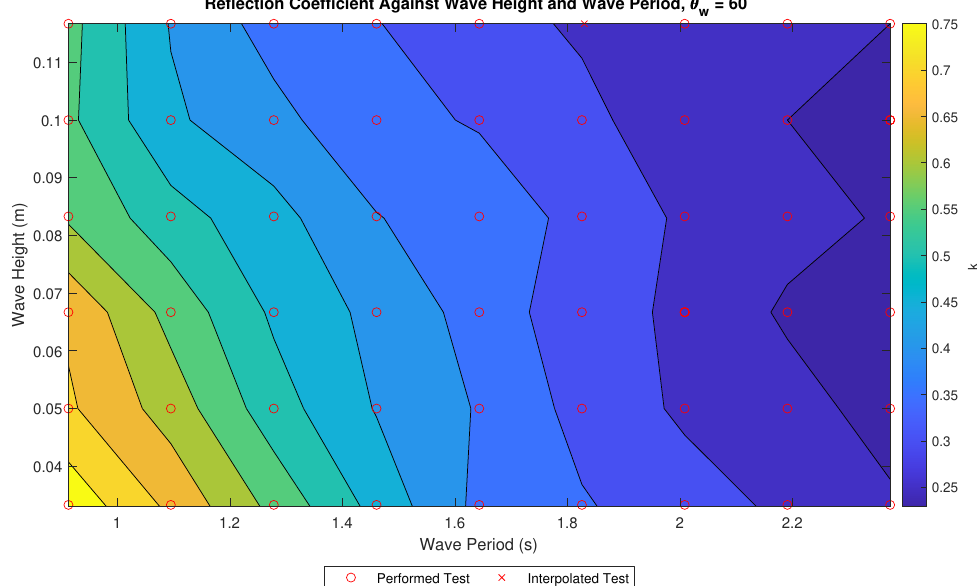
Figure 8. K r against significant wave height and peak wave period.